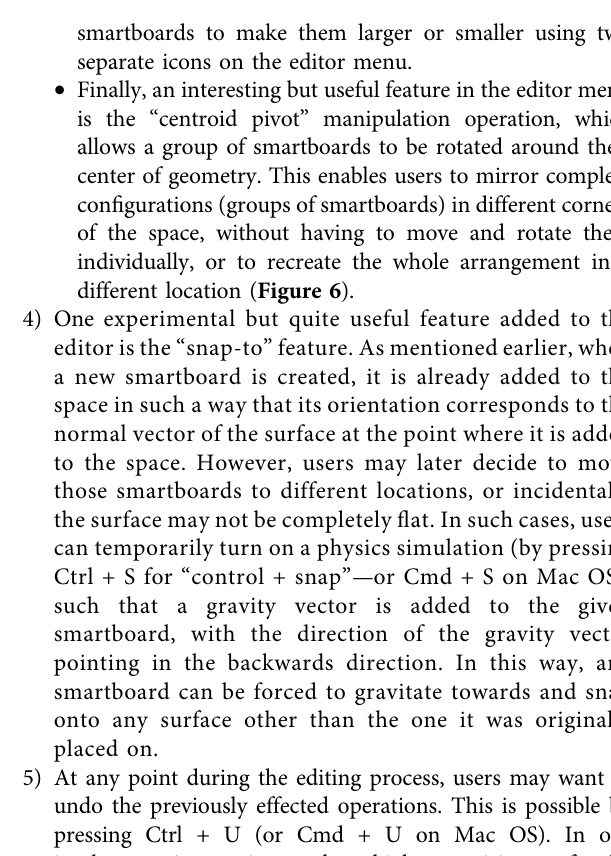
Frontiers in Computer Science |